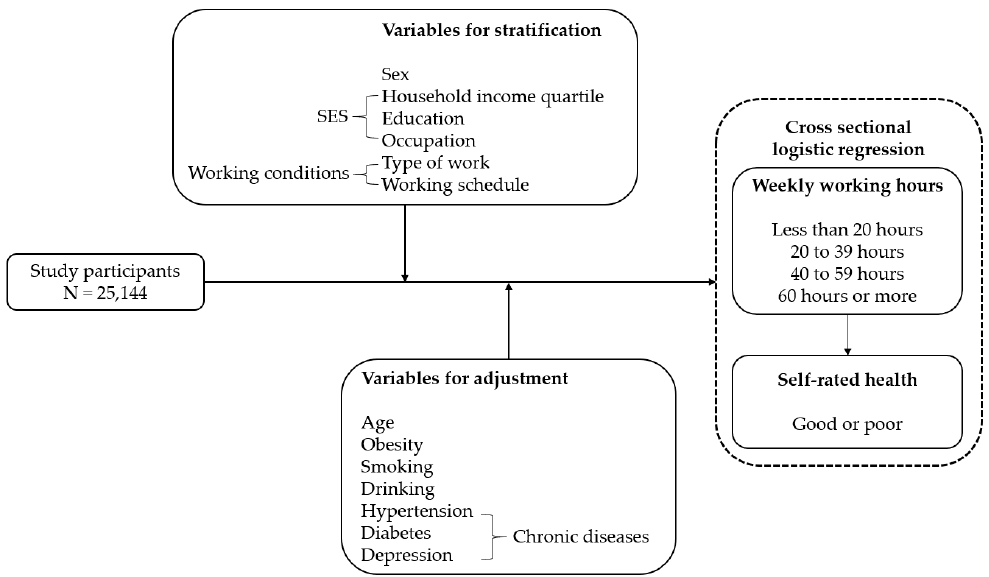
Figure 2. Analytical framework of current study.